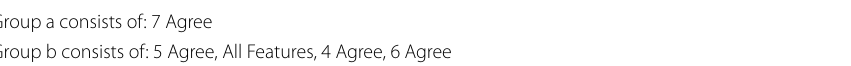
Table 27 HSD test groupings after ANOVA of AUC for the FST factor